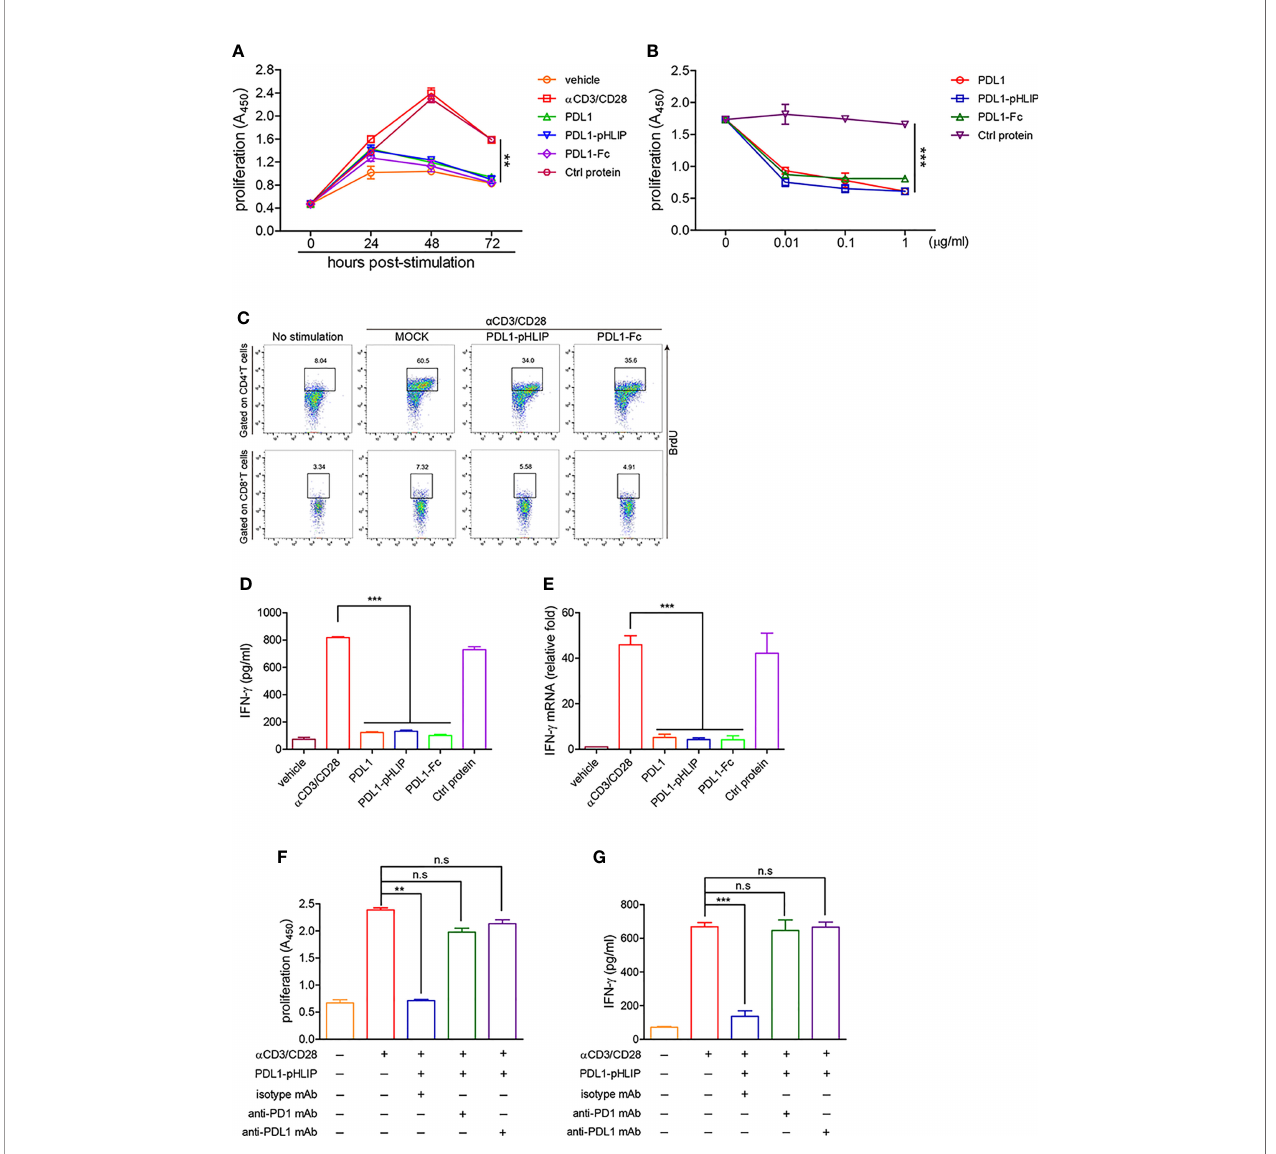
FIGURE 5 | The capacity of immobile PD-L1-pHLIP to inhibit lymphocyte proliferation and IFN- g production. (A) PD-L1/PD-L1-pHLIP/PD-L1-Fc or control protein (0.1 m g/ml) were coated in culture plates overnight. Mouse lymphocytes were isolated and stimulated with a CD3/CD28 antibodies for 0 – 72 h. The proliferation was determined by BrdU cell proliferation assays. (B) Mouse lymphocytes were stimulated with a CD3/CD28 antibodies in the absence or presence of immobile PD-L1/ PD-L1-pHLIP/PD-L1-Fc (0 – 1 m g/ml) for 72 h. The proliferation was determined by BrdU cell proliferation assays. (C) Mouse lymphocytes were stimulated with a CD3/ CD28 antibodies in the presence of immobile PD-L1/PD-L1-pHLIP/PD-L1-Fc (0.1 m g/ml) for 72 h. BrdU (10 m M) was incorporated at last 6 h. The proliferation of CD4 + or CD8 + T lymphocytes was determined by fl ow cytometry. (D, E) Mouse lymphocytes were stimulated with a CD3/CD28 antibodies in the presence of immobile PD-L1/PD-L1-pHLIP/PD-L1-Fc (0.1 m g/ml) for 72 h. IFN- g expression was examined by ELISA (D) and quantitative RT-PCR (E) , respectively. (F, G) Mouse lymphocytes were stimulated with a CD3/CD28 antibodies in the presence of immobile PD-L1/PD-L1-pHLIP/PD-L1-Fc (0.1 m g/ml) for 72 h. Monoclonal antibodies to PD-1 or PD-L1 or isotypes (10 m g/ml) were added in the culture. The proliferation was determined by BrdU cell proliferation assays (F) . IFN- g production in the supernatants was examined by ELISA (G) . Representative plots from three independent experiments were shown. The data were pooled from fi ve independent experiments with similar results. ** p < 0.01; *** p < 0.001; n.s., no signi fi